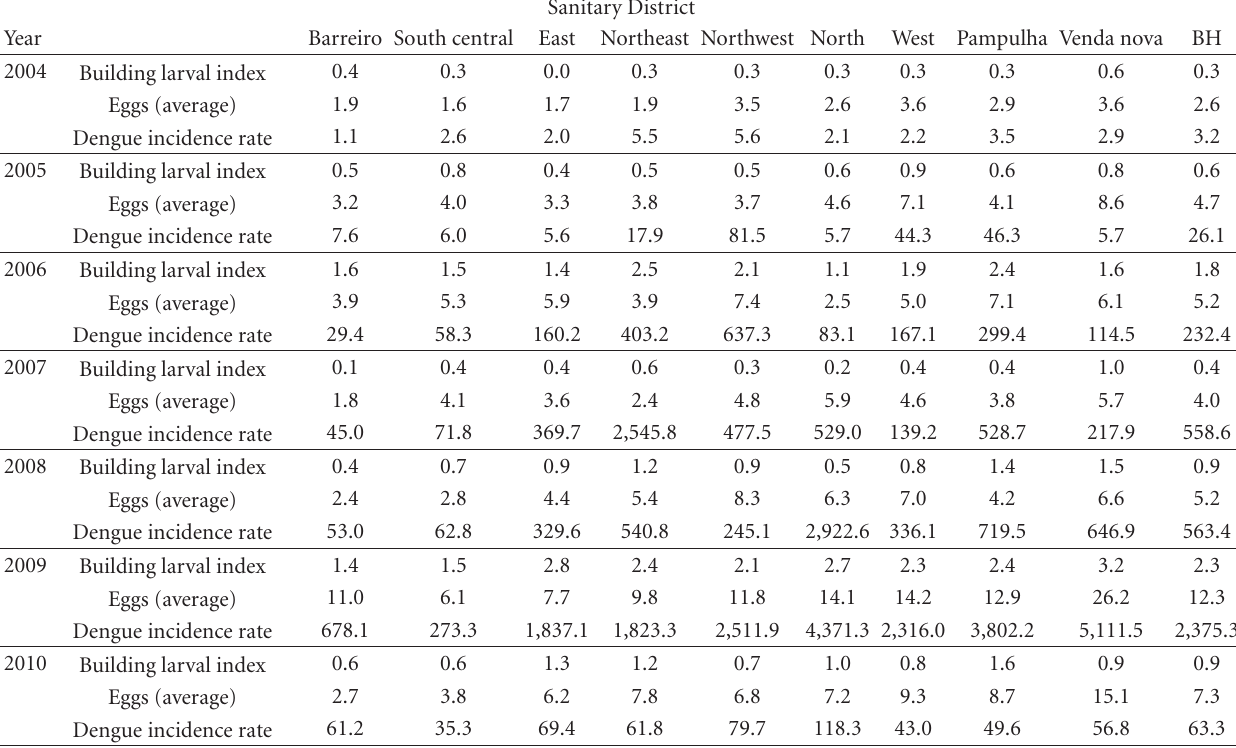
Table 1: Building larval index (BLI) in October larval foci survey, eggs average (EA) in September-October survey, and dengue incidence rates (DIR) per 100,000 inhabitants in subsequent years, by Sanitary District, Belo Horizonte city,